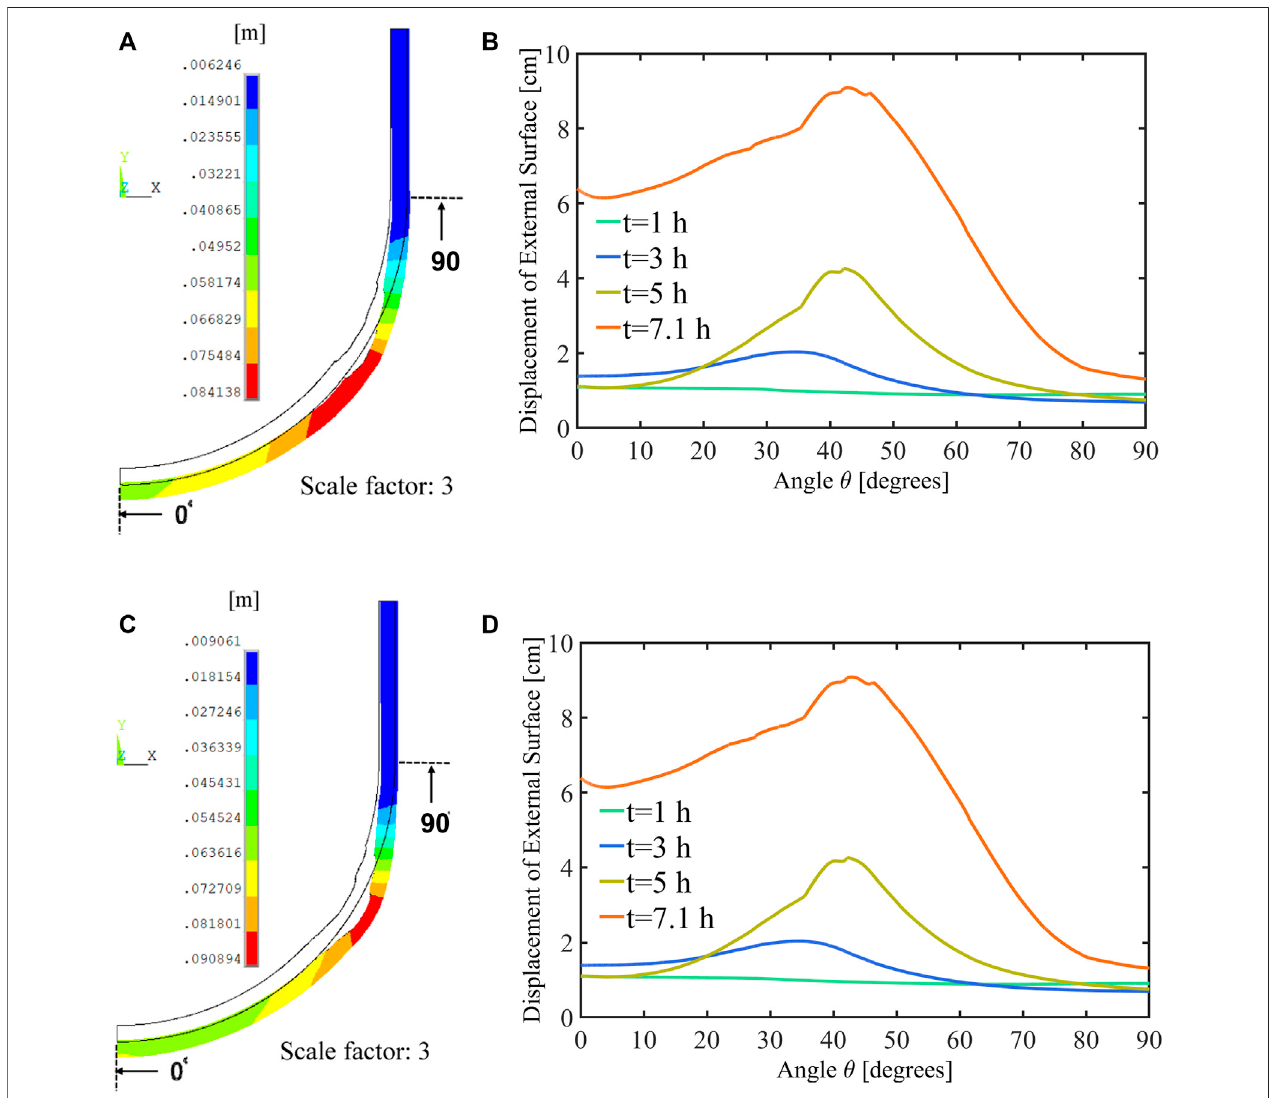
FIGURE15|(A) Vector sumofdisplacement(scalefactor =3)at t =6.8 h(failuretime)fortheSBOcase. (B) Displacementoftheexternalvesselsurfaceat t =1,2, 3, and 6.8 h for the SBO case. (C) Vector sum of displacement (scale factor = 3) at t = 7.1 h (failure time) for the SBO + LOCA case. (D) Displacement of the external vessel surface at t = 1, 2, 3, and 7.1 h for the SBO + LOCA case.